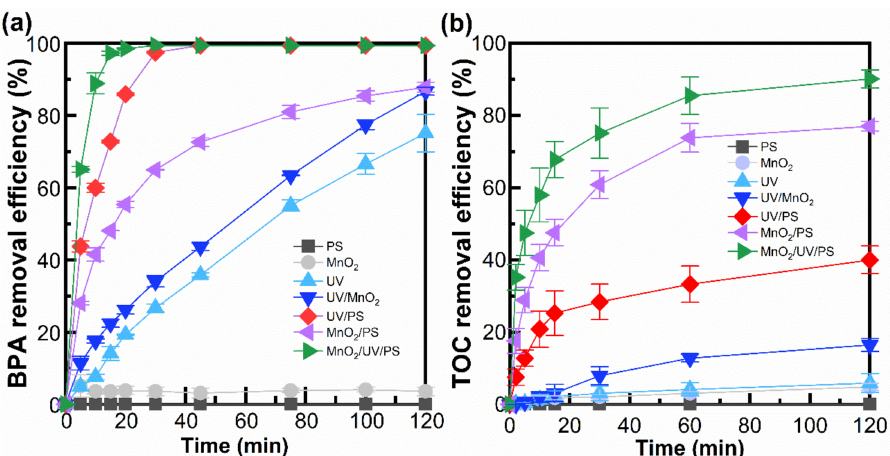
Figure 1. BPA ( a ) and TOC ( b ) removal over time using the PS, MnO 2 , UV, UV/MnO 2 , MnO 2 /PS, UV/PS, and MnO 2 /UV/PS processes. Conditions at t = 0 min: [BPA] = 30 mg/L, [PS] = 1 mM, [MnO 2 ] = 0.25 g/L, pH = 6.5, T = 22–25 ◦